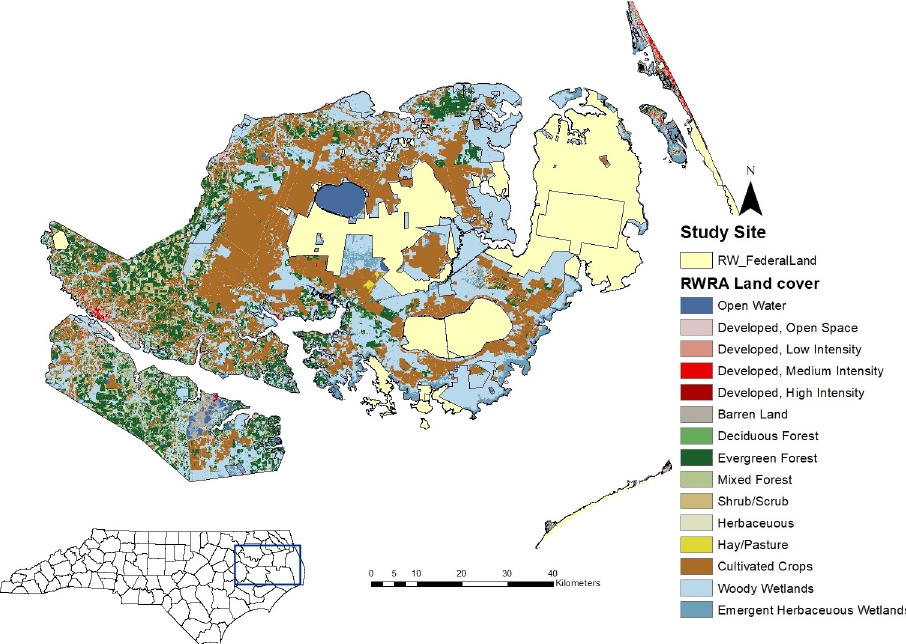
Fig 1. Red wolf recovery area (RWRA) in NENC showing federal and state-owned lands and land cover types